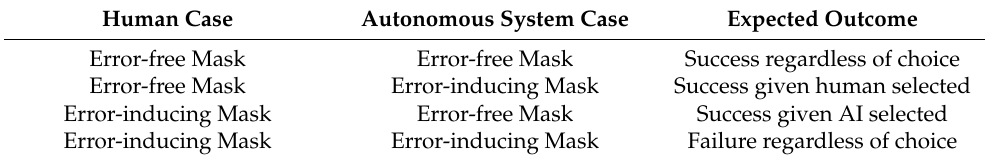
Table 4. Human–AI pair cases.